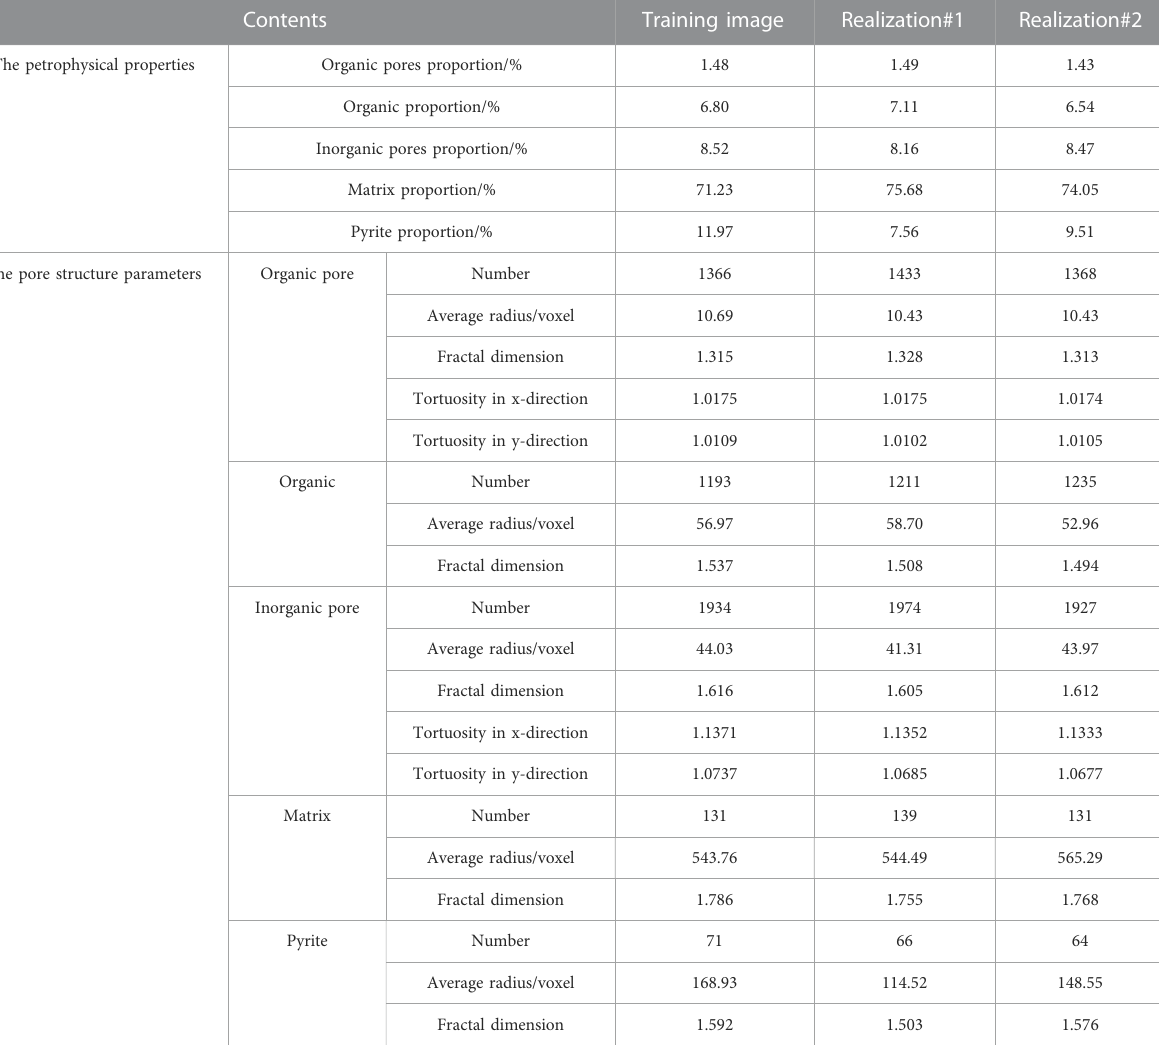
TABLE 3 Petrophysical properties and pore structure parameter of the training image and the realizations obtained by segmenting the reconstructed gray